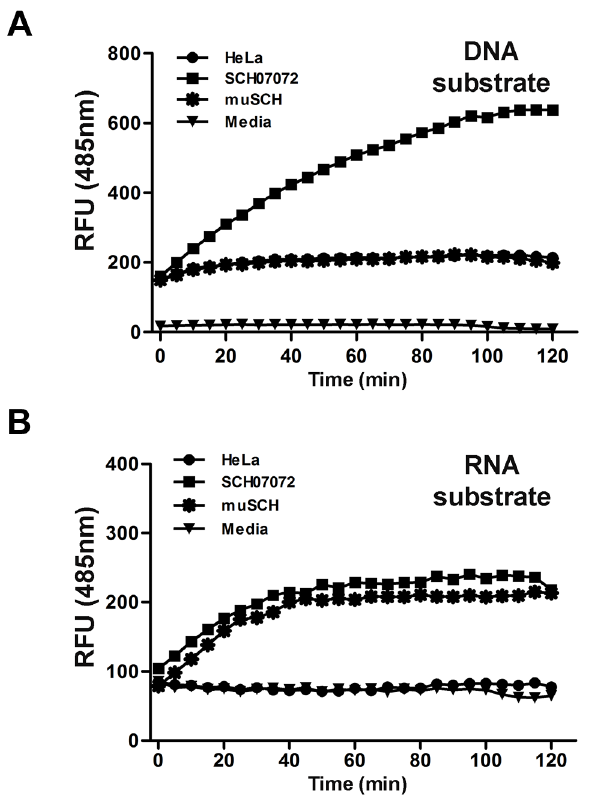
Figure 4. 3D8 scFv protein have DNase and RNase activity in vitro (FRET assay). A . DNA substrate (dsDNA) labeled with 6- carboxyfluorescein (FAM) was transferred into the different cell lines using Lipofectamine. RFUs were determined by measuring the absorbance at 485 nm. Background fluorescence was measured in wells with medium only. SCH07072 cells produced fluorescence counts up to 660 RFU 80 min after treatment. B . RNA substrate (ssRNA) labeled with 6-carboxyfluorescein (FAM) was transferred into the different cell lines using Lipofectamine. Fluorescence was determined by measuring absorbance at 485 nm. Background fluorescence was measured in wells with medium only. SCH07072 and muSCH had fluorescence levels of approximately 200 RFU in contrast to the fluorescence counts of wild- type HeLa cells and the negative control reactant, which were approximately 80